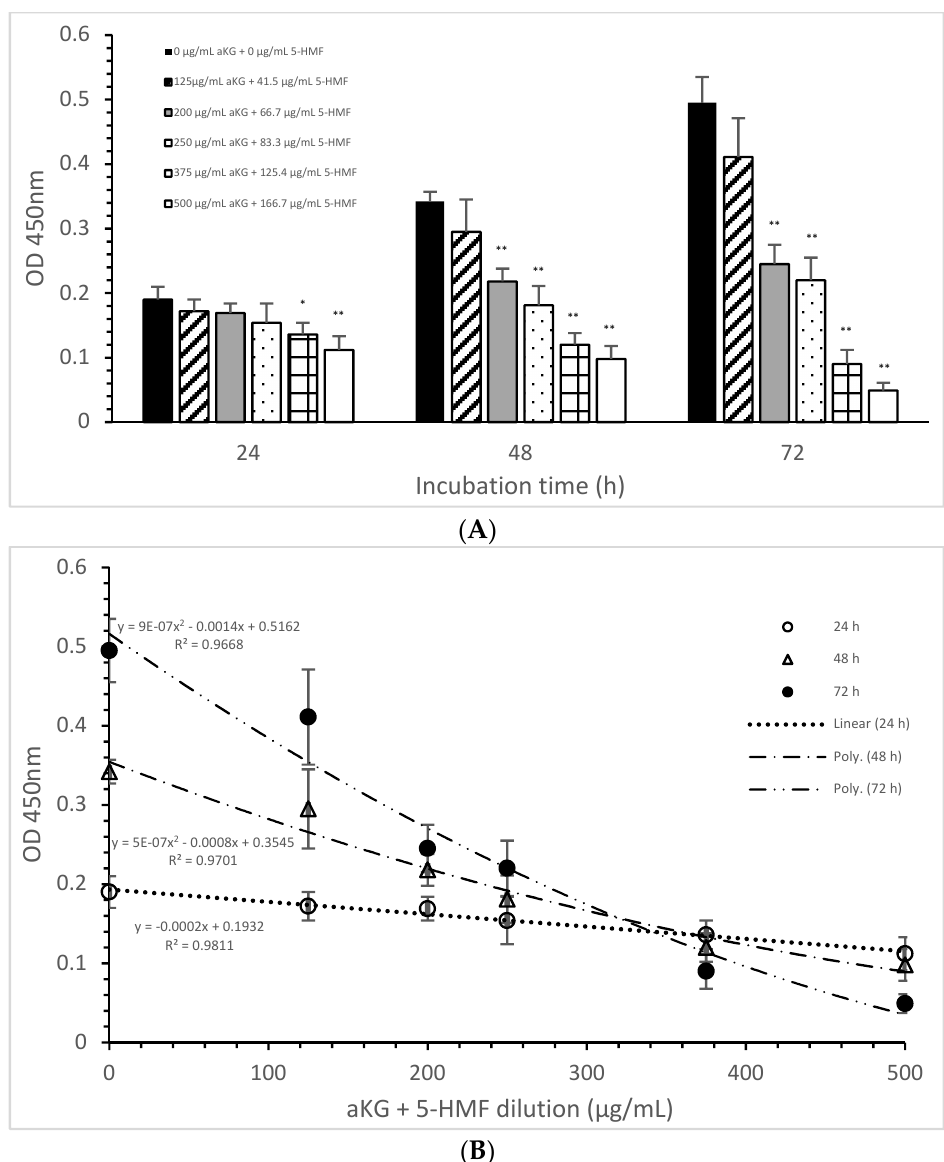
Figure 3. Mitochondrial activity of the Jurkat cell line in the absence or presence of different aKG + 5-HMF concentrations ( A ); ( B ) correlation between mitochondrial activity and the combined aKG + 5-HMF concentration after 24, 48, and 72 h of cultivation ( n = 5). * p < 0.01: significance between the control (0 µg/mL aKG + 0 µg/mL 5-HMF) and different combinations of aKG + 5-HMF at time points after 24, 48, and 72 h of cell culture. ** p < 0.001: significance between the control (0 µg/mL aKG + 0 µg/mL 5-HMF) and different combinations of aKG + 5-HMF at time points after 1, 2, and 3 days of cell culture.